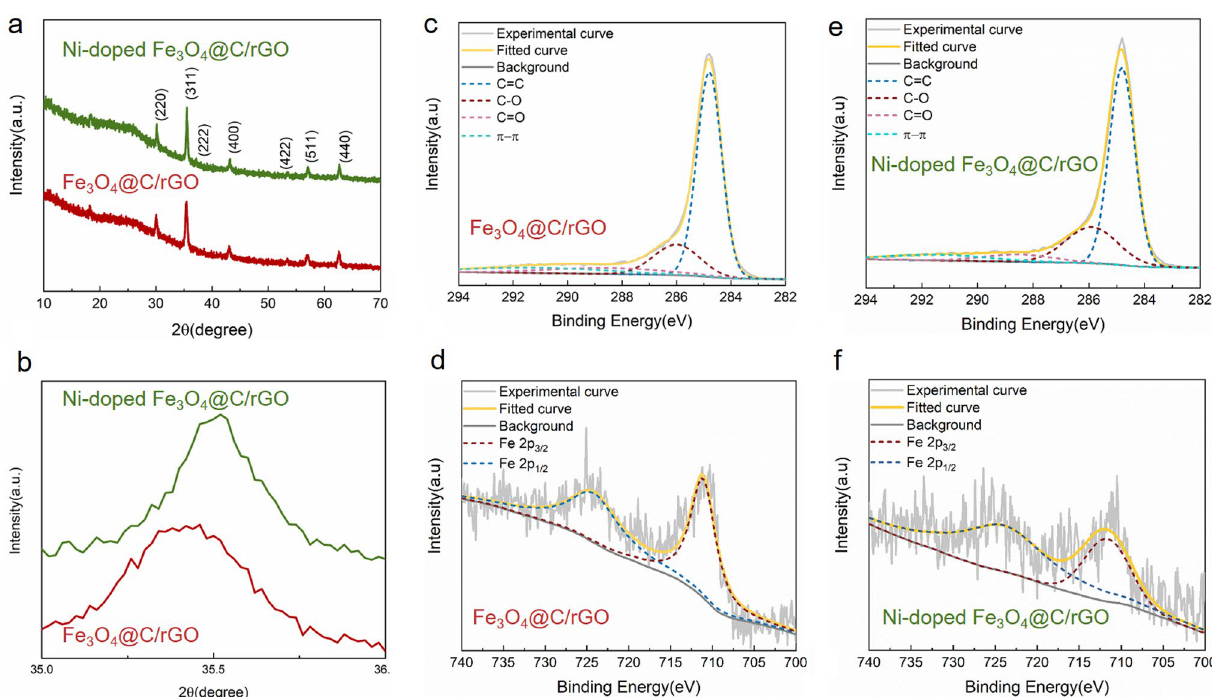
Fig. 5 a‑b XRD patterns and c – f high-resolution XPS spectra of c, e C 1 s and d, f Fe 2 p of Fe 3 O 4 @C/rGO and Ni-doped Fe 3 O 4 @C/rGO aero-